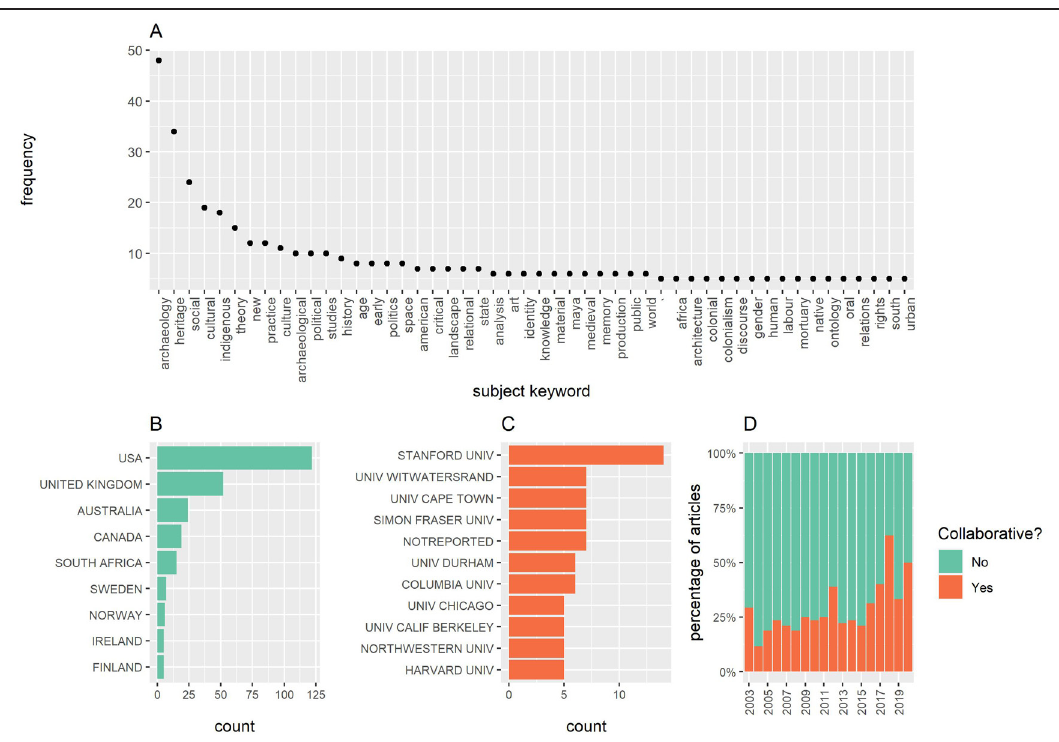
Figure 15: Journal of Social Archaeology summary plot ( a – word frequency from article titles, b – institution country top ten, c – author institution top ten, d – single vs multi-author over